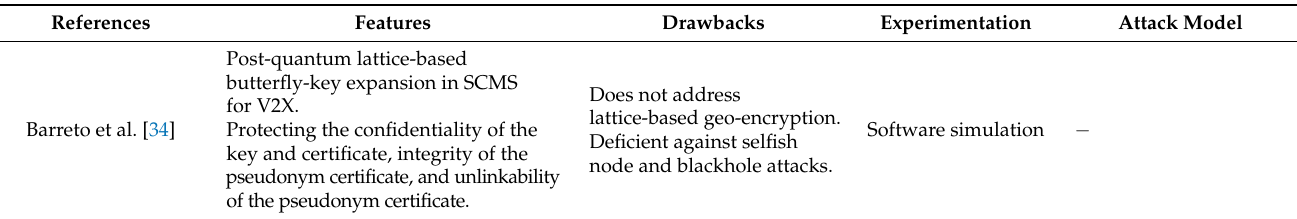
Table 1. Overview of literature